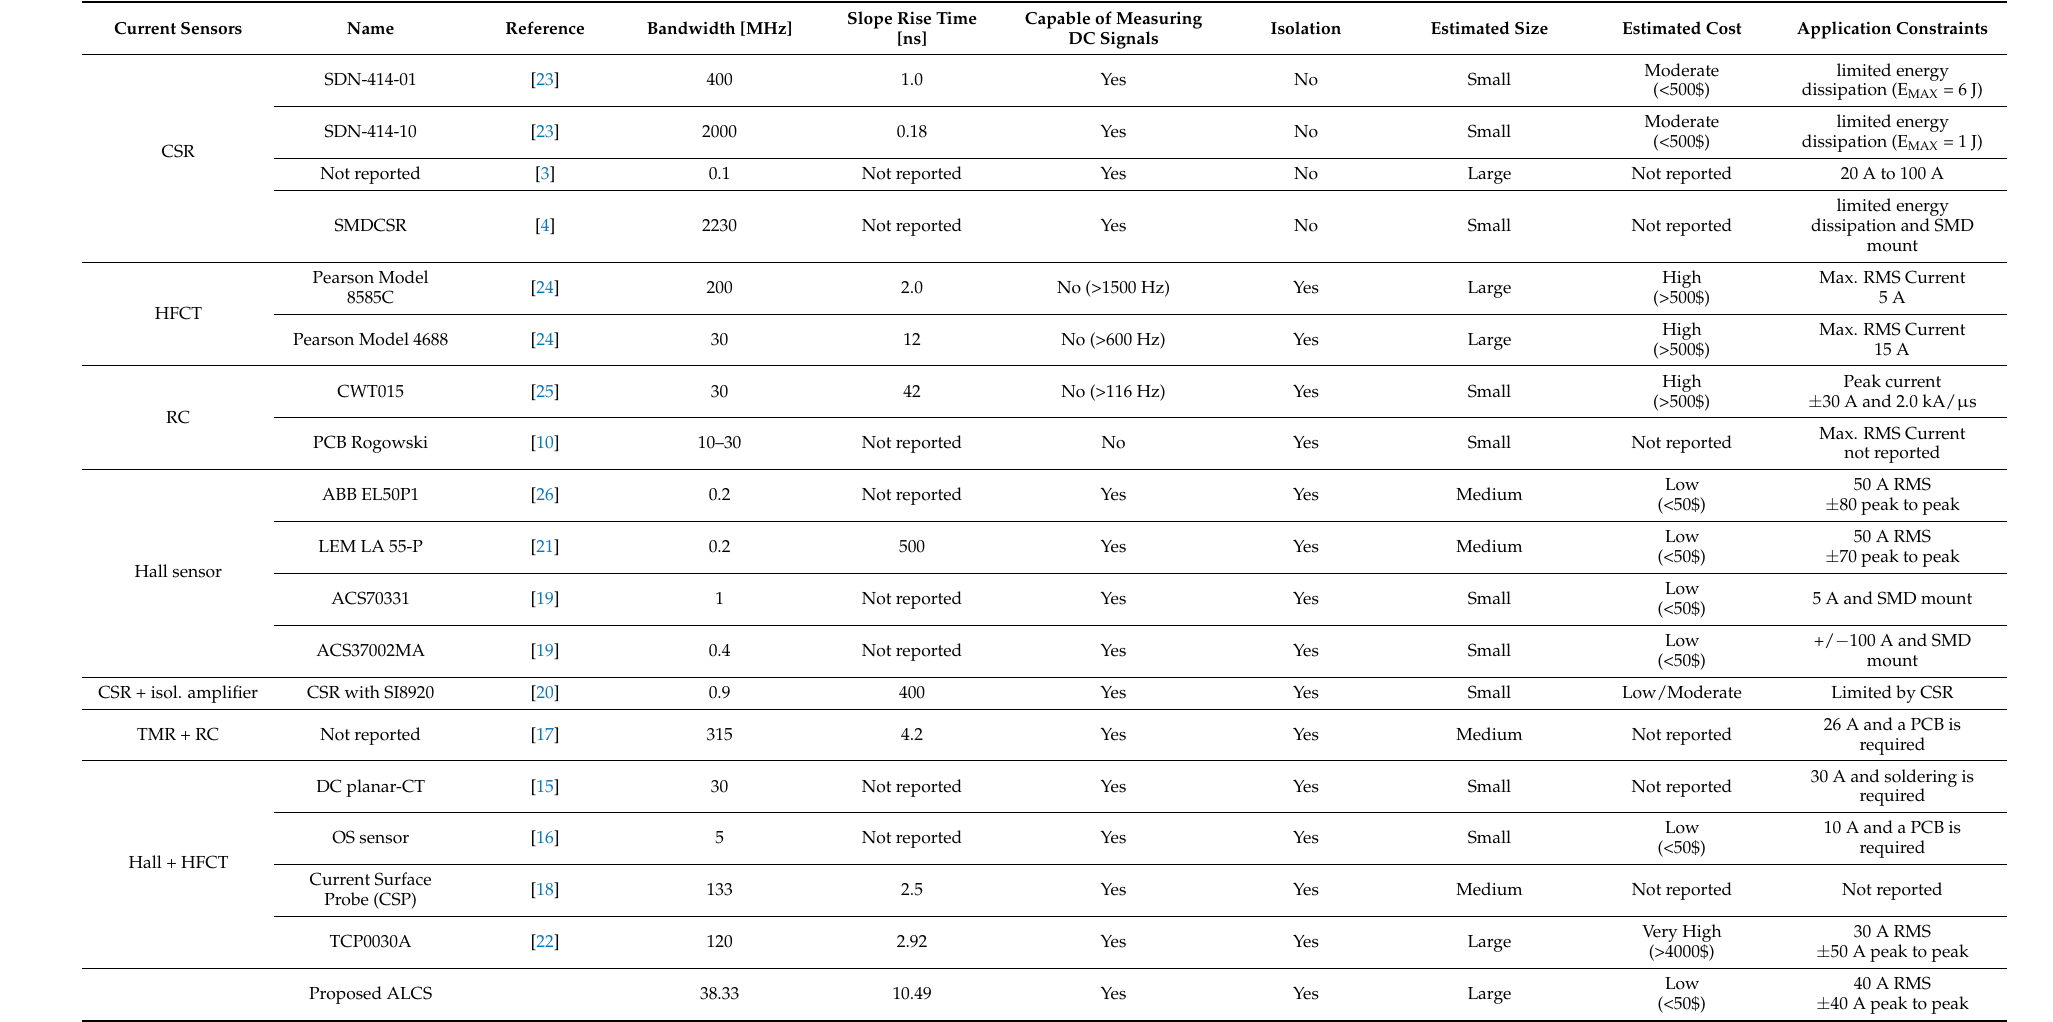
Table 1. The general summary of power electronics current